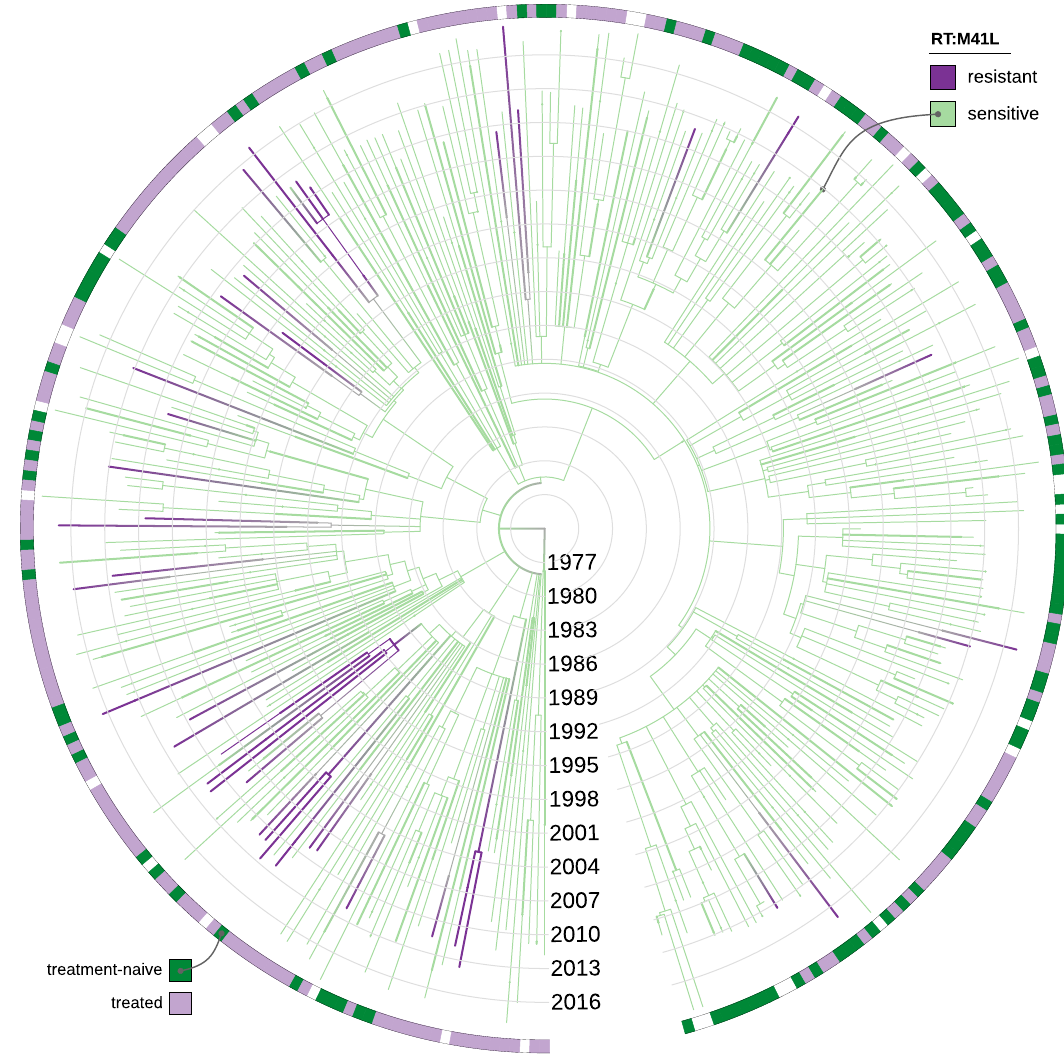
Fig 4. ACR for the presence of RT:M41L DRM in the CRF19-infected individuals. ACR is done with PastML [18] (MPPA+F81), the visualisation is performed with iTOL [19]. Nodes and branches are coloured by RT:M41L (violet for resistant (the mutation is present), light-green for sensitive). The colourstrip around the tree shows the treatment status of the sampled individuals (dark- green for treatment-na ï ve, lilac for treatment-experienced). unlikely that the recombination event took place in Cuba considering that (1) we traced MRCA for CRF19 back to 1977 or before, (2) the first Cuban HIV-1 patients were not diag- nosed until 1986, (3) the non-recombinant A1/D/G-subtype Cuban sequences in our data sets were estimated to be introduced to Cuba after 1977 (1982 for G, 1996 for A1 and in the 2010 s for D), while (4) recombination had to occur in a scenario of co-circulation of subtypes A, D, and G. Moreover, countries from sub-Saharan Africa were proposed to be sites of origin for other AG and AD recombinants within the same period of time [26, 27]. All together, we can conclude that CRF19 was among the very first CRFs/subtypes to be introduced in Cuba, by the mid of 1970 s . Other subtypes have undergone the same journey, from Central Africa to the Caribbean, for example subtype B, which was present in Haiti since the end of the 1960s [28]. However, while subtype B rapidly reached the USA and then Europe and the rest of the world,